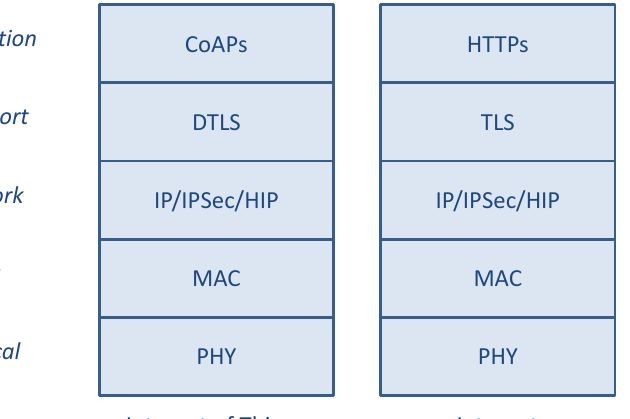
Figure 2. Comparison between the Internet and the IoT security